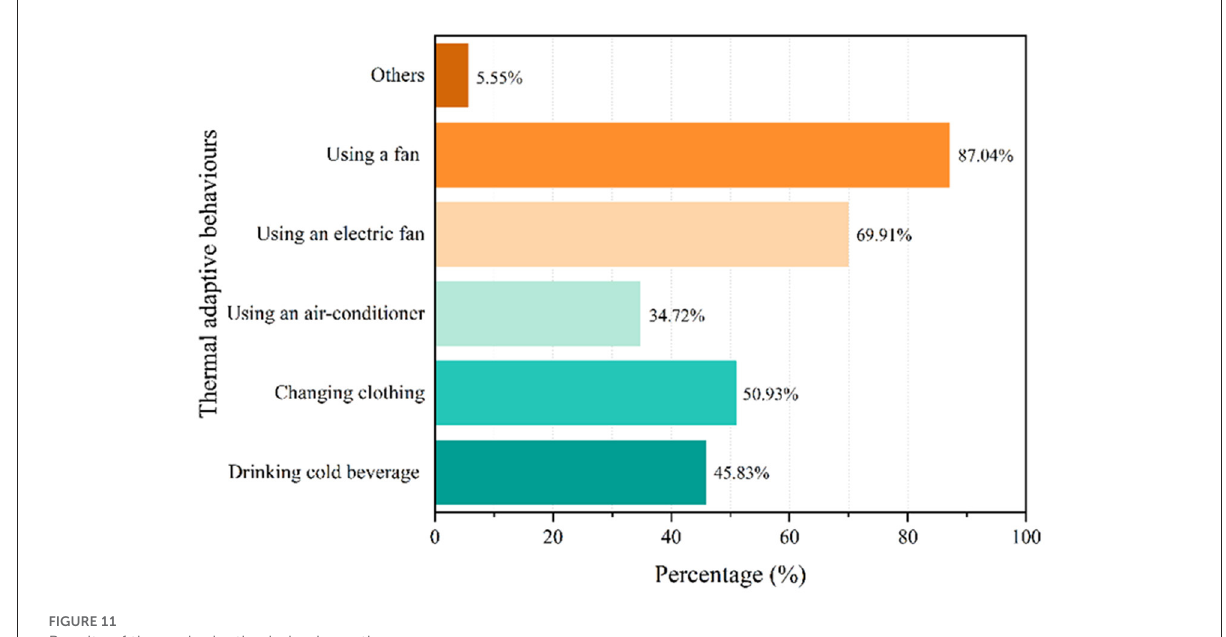
FIGURE11 Results of thermal adaptive behavior voting.